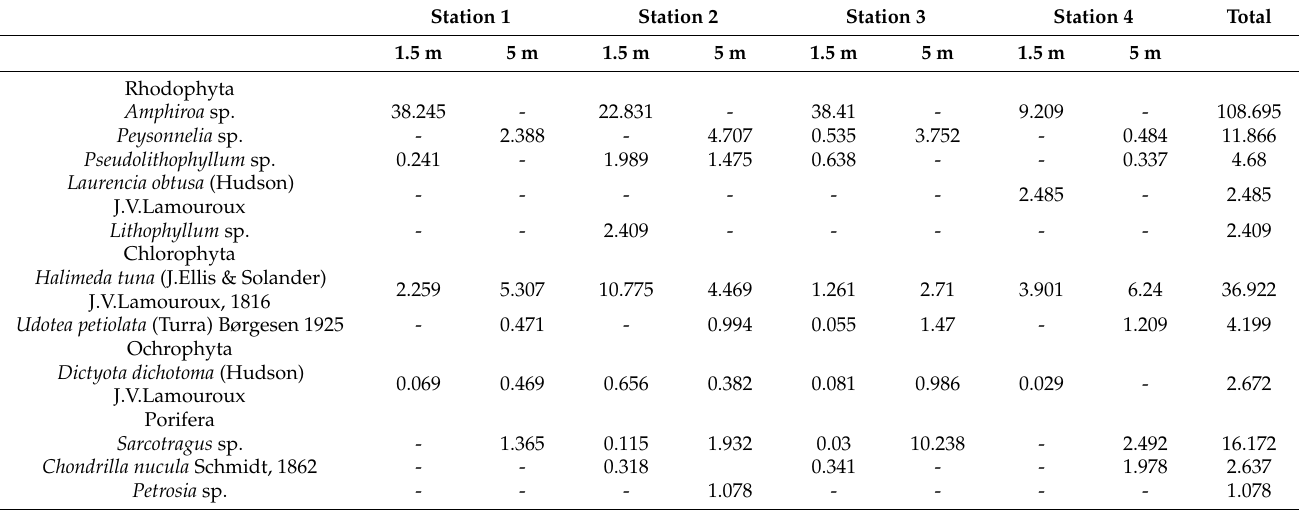
Table A1. Abundance (dry weight in grams) of structuring macrobenthos taxa collected at Torre Guaceto MPA.